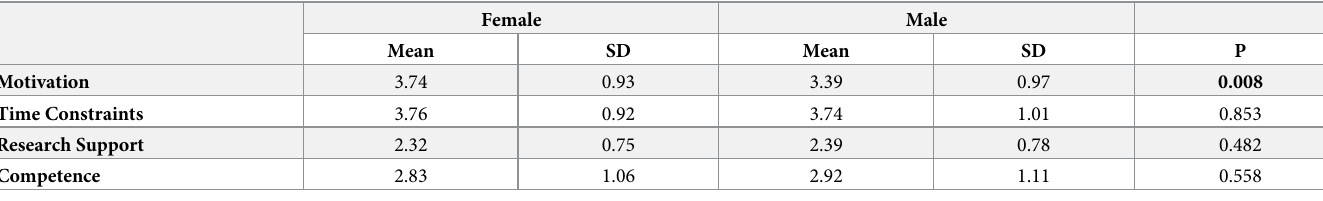
Table 3. Answers are given to the research barriers scale by